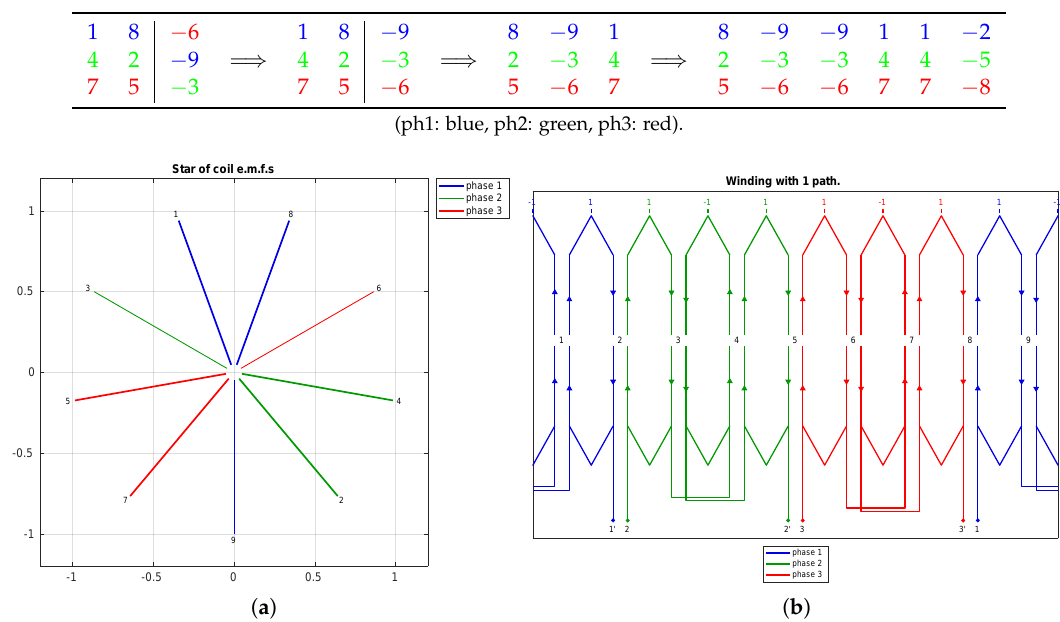
Figure 9. ( a ) Star of slots and ( b ) winding configuration for a double-layer, three-phase concentrated winding with N = 9, p = 4 and m = 3.